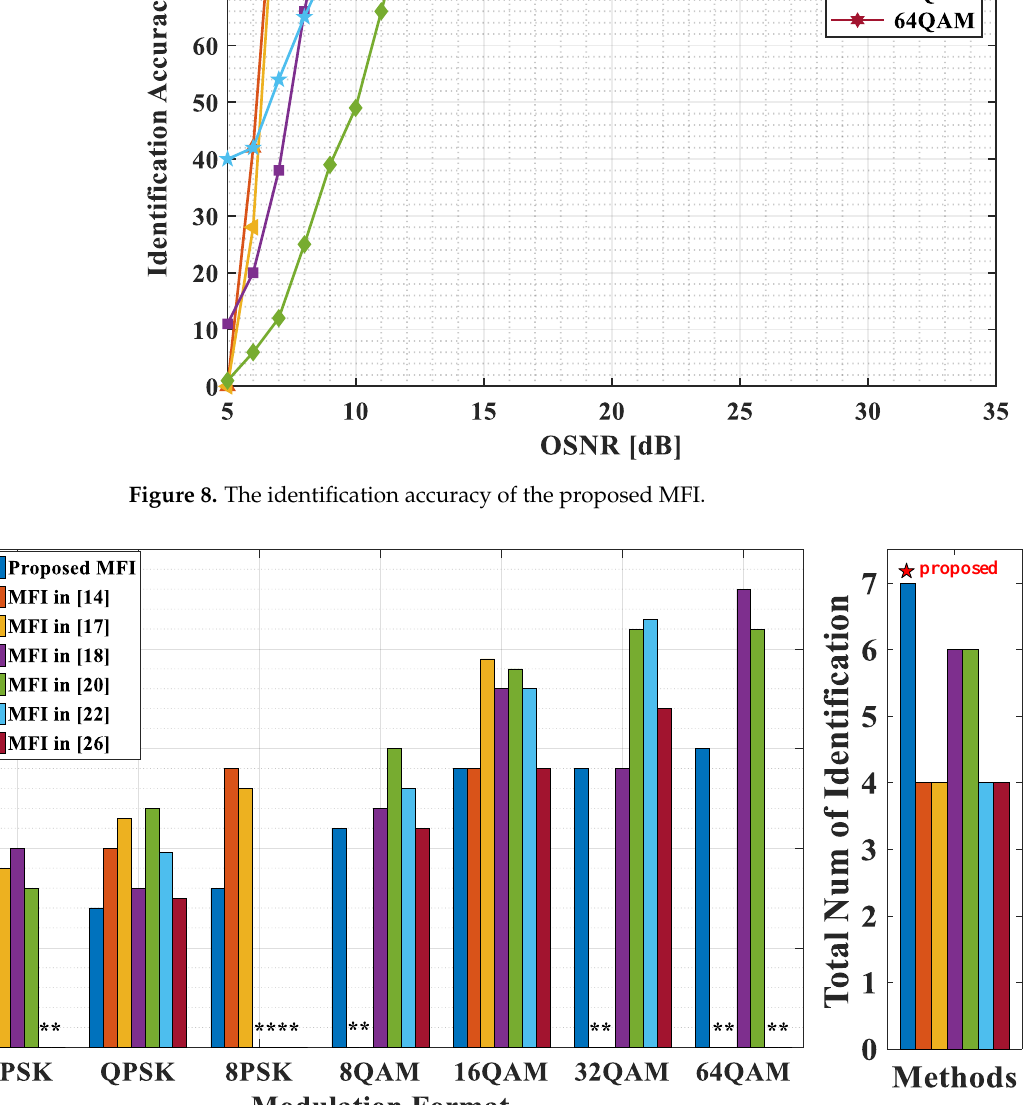
Figure 9. Performance comparison between the proposed method and the methods in the other literature, where * indicates that there is no identification result at the corresponding